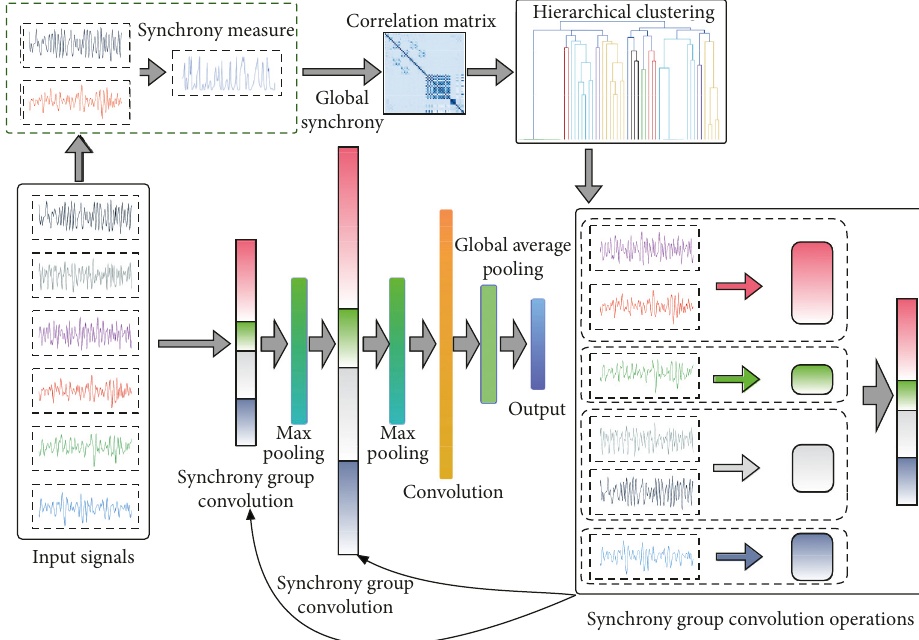
Figure 4: The proposed framework based on synchrony group convolutions for fault diagnosis of the high-speed